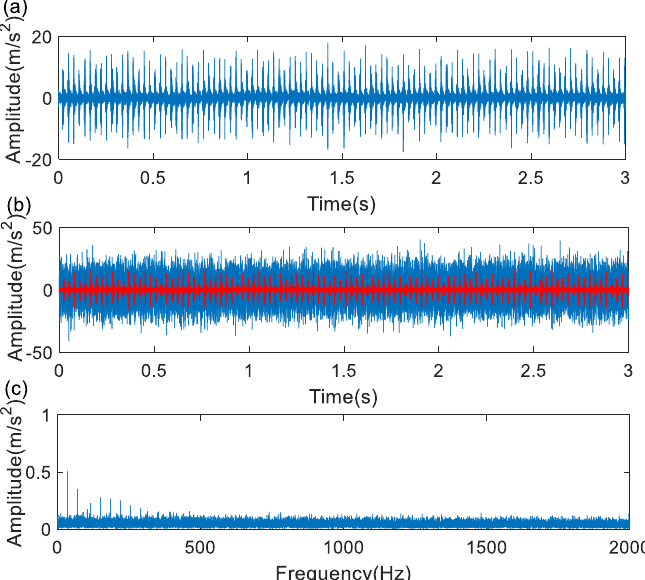
Figure 9. The inner ring fault signal: ( a ) original signal; ( b ) noisy signal; ( c ) envelope spectrum.